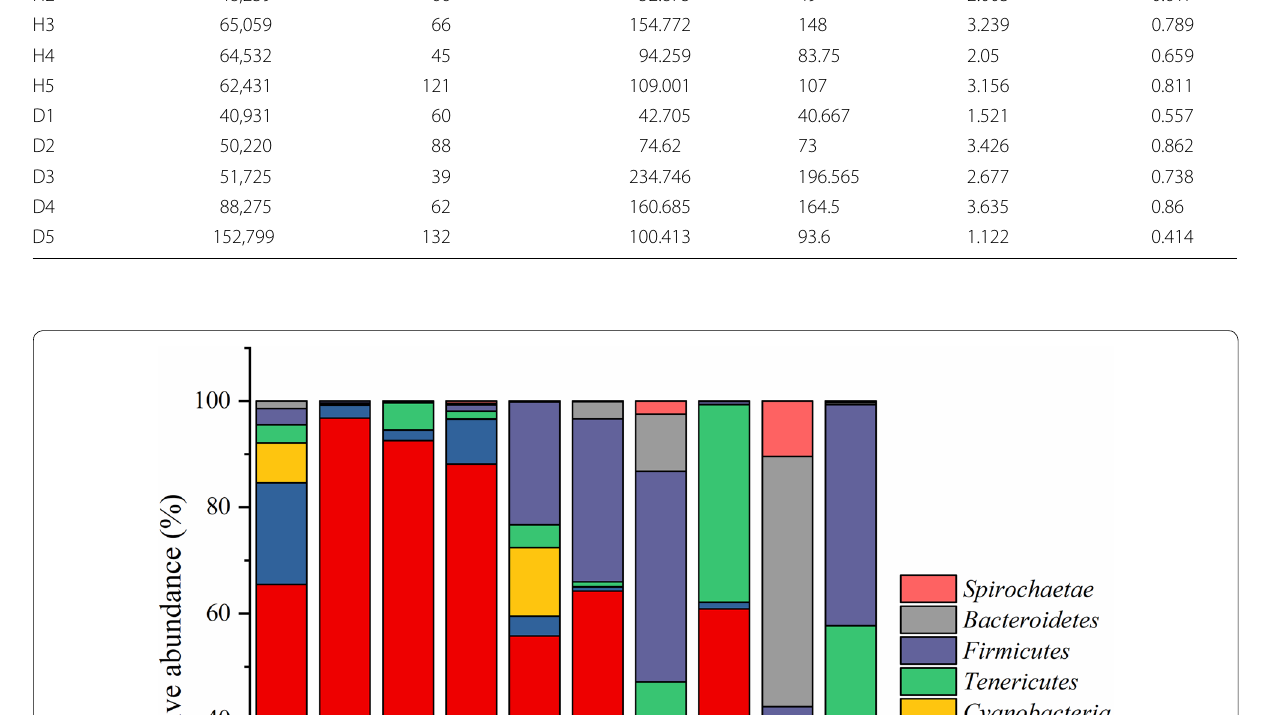
diseased crabs, respectively. (Figure 2, Additional file 1: Fig. S1, and Table S1). Variation in bacterial community structure across health status The α-diversity indices showed similar intestinal bacterial richness (Ace, Chao1) and diversity (Shannon, Simpson) between the healthy and diseased crabs (independent t test,F 1.801, 1.221, 1.736, and 3.480; P =